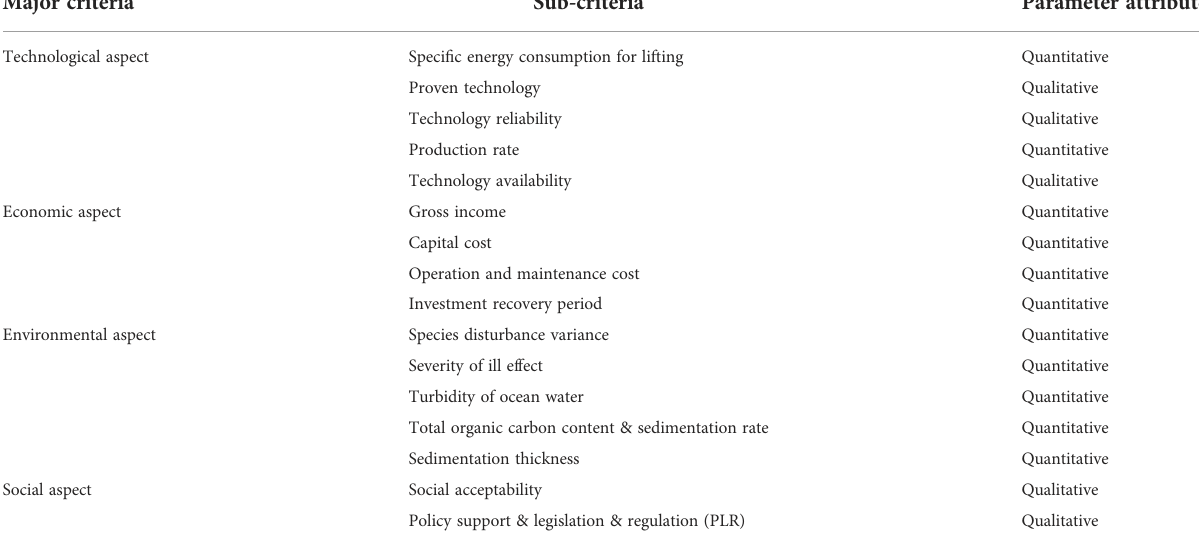
TABLE 1 Evaluation criteria for selecting a sustainable DSM transport plan (Akash et al., 1999; Mamlook et al., 2001; Yedla and Shrestha, 2003; Begic ́ and Afgan, 2007; McDowall and Eames, 2007; Afgan and Carvalho, 2008; Chatzimouratidis and Pilavachi, 2009; Jovanovic ́ et al., 2009; Pilavachi et al., 2009; Pilavachi et al., 2009; Campos-Guzma ́ n et al., 2019; Drazen et al., 2020; Gerber and Grogan, 2020; Ma et al.,